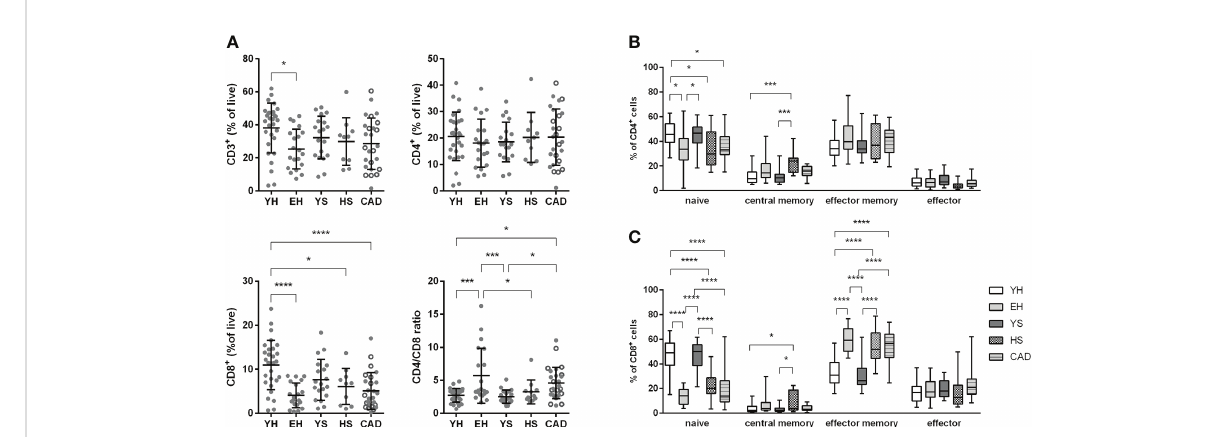
FIGURE 4 Effect of ageing and smoking on T cells and memory subsets. Percentage of CD3 + , CD4 + and CD8 + T cells of total CD45 + leukocytes was measured by fl ow cytometry (A) . Naïve (CCR7 + CD45ro - ) and memory subsets (central memory: CCR7 + CD45ro + , effector memory: CCR7 - CD45ro + ) were quanti fi ed for CD4 + T cells (B) as well as CD8 + T cells (C) . YH, young healthy; EH, elderly healthy; YS, young smoker; HS, heavy smoker; CAD, coronary artery disease patient. Open circles in the CAD group represent smokers. Statistics was performed using one-way ANOVA with Dunnett ’ s post hoc test, means were compared to the YH group. P values ≤ 0.05 are considered signi fi cant. * p ≤ 0.05, *** p ≤ 0.001, **** p ≤